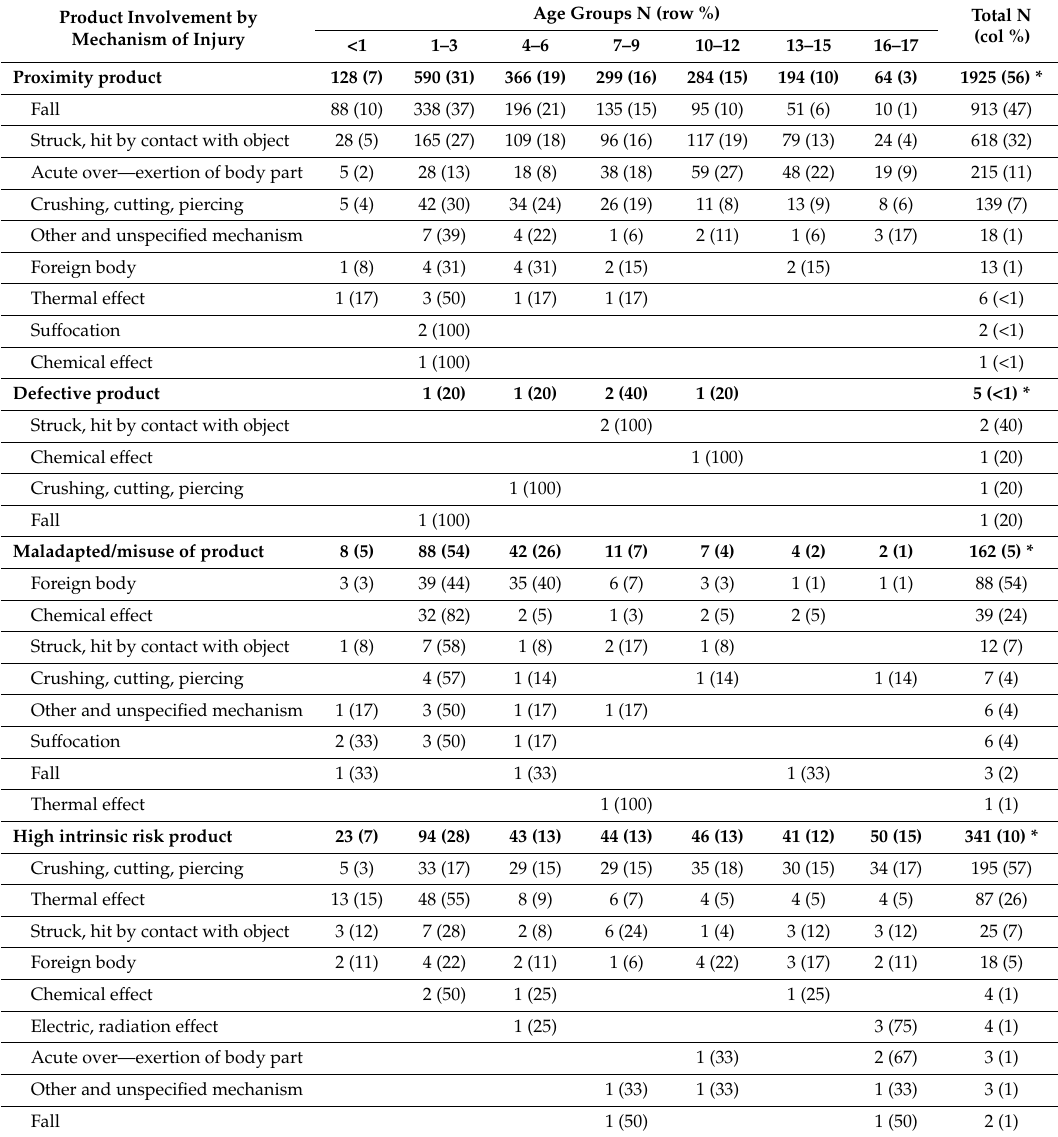
Table 3. Consumer product involvement in different mechanism of injury by age